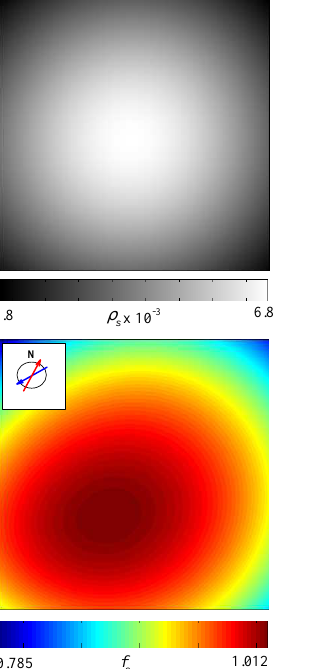
Figure 4. Illumination correction. Rahman BDRF at noon (upper panel), BDRF factor (lower panel),in the upper-left inset f f 1 (red arrow) and 2 (blue arrow)